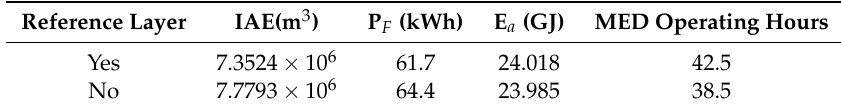
Table 2. Results for Days